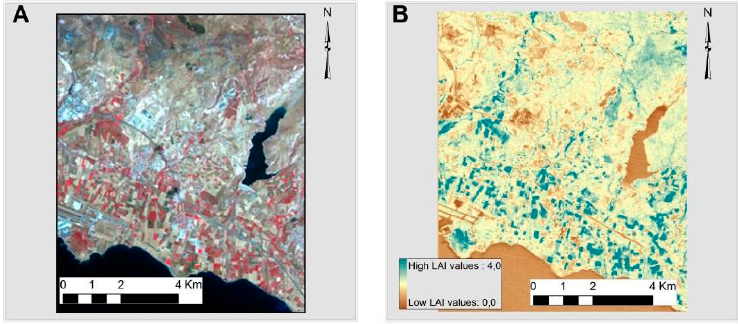
Figure 5. Generation of LAI ( B ) (in pseudo color) using Landsat images ( A ) (Landsat 7 ETM+ images).